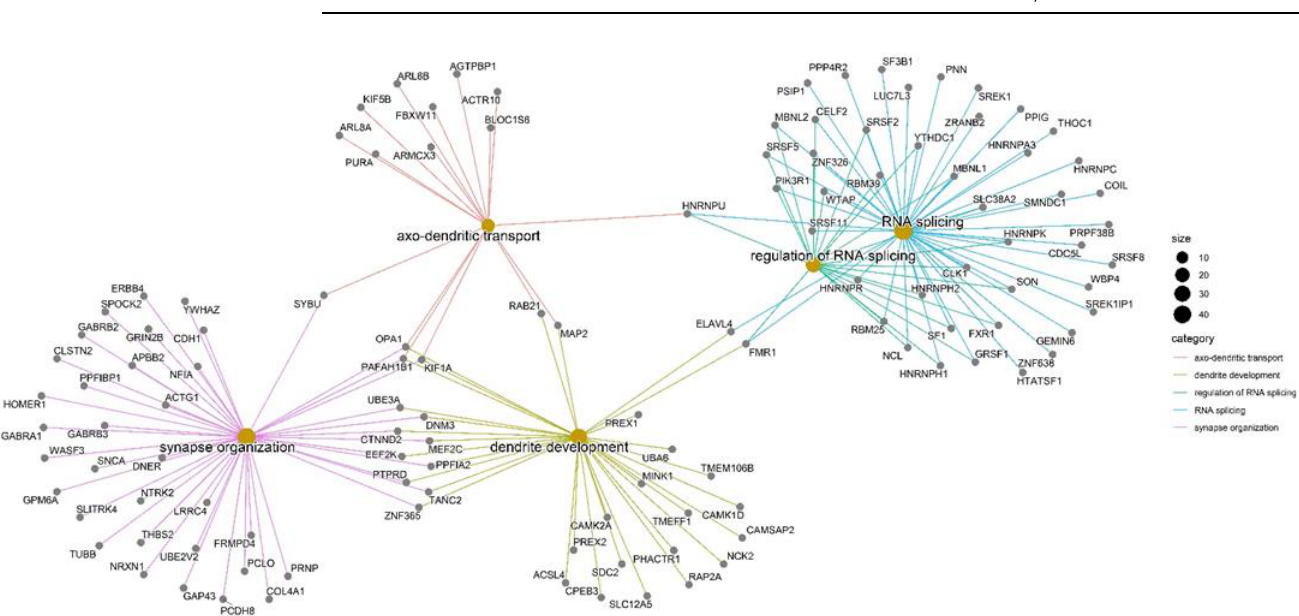
Figure 1. Enrichment network for results obtained from the hypergeometric enrichment test: linkages of genes, GO biological process, and enriched terms are connecting overlapping gene sets.